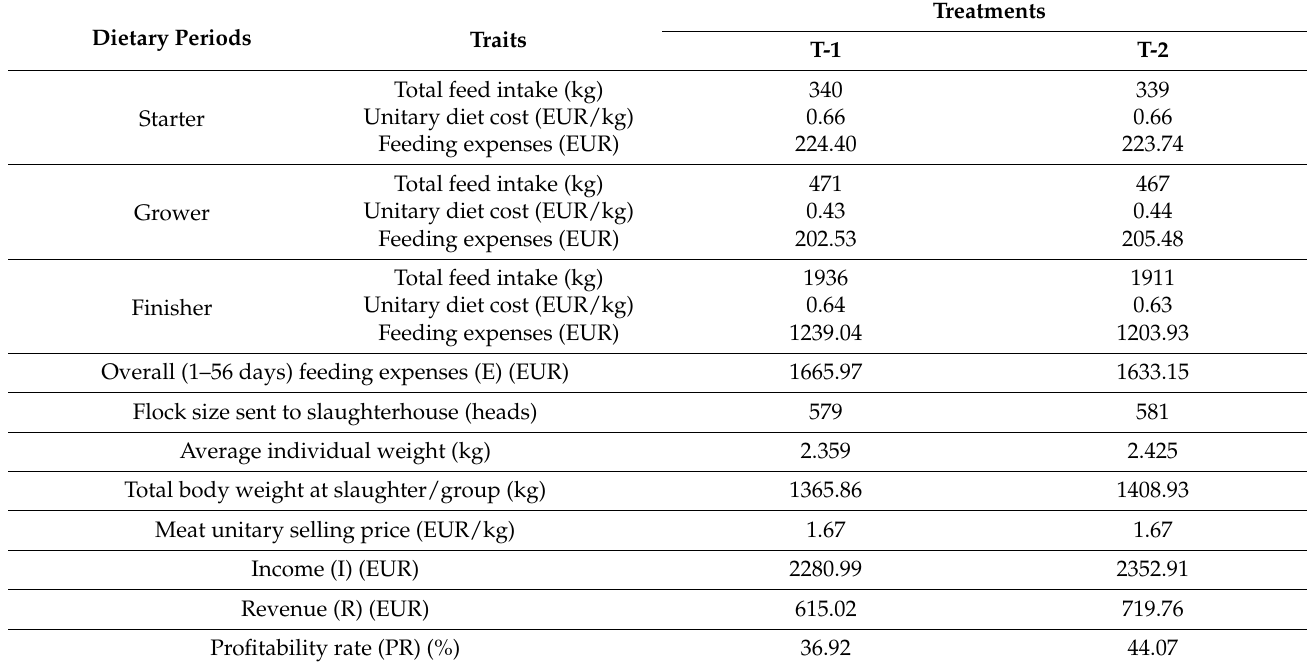
Table 6. Economic efficacy indices (Expense, Incomes, Revenue, and Rate of Profitability).